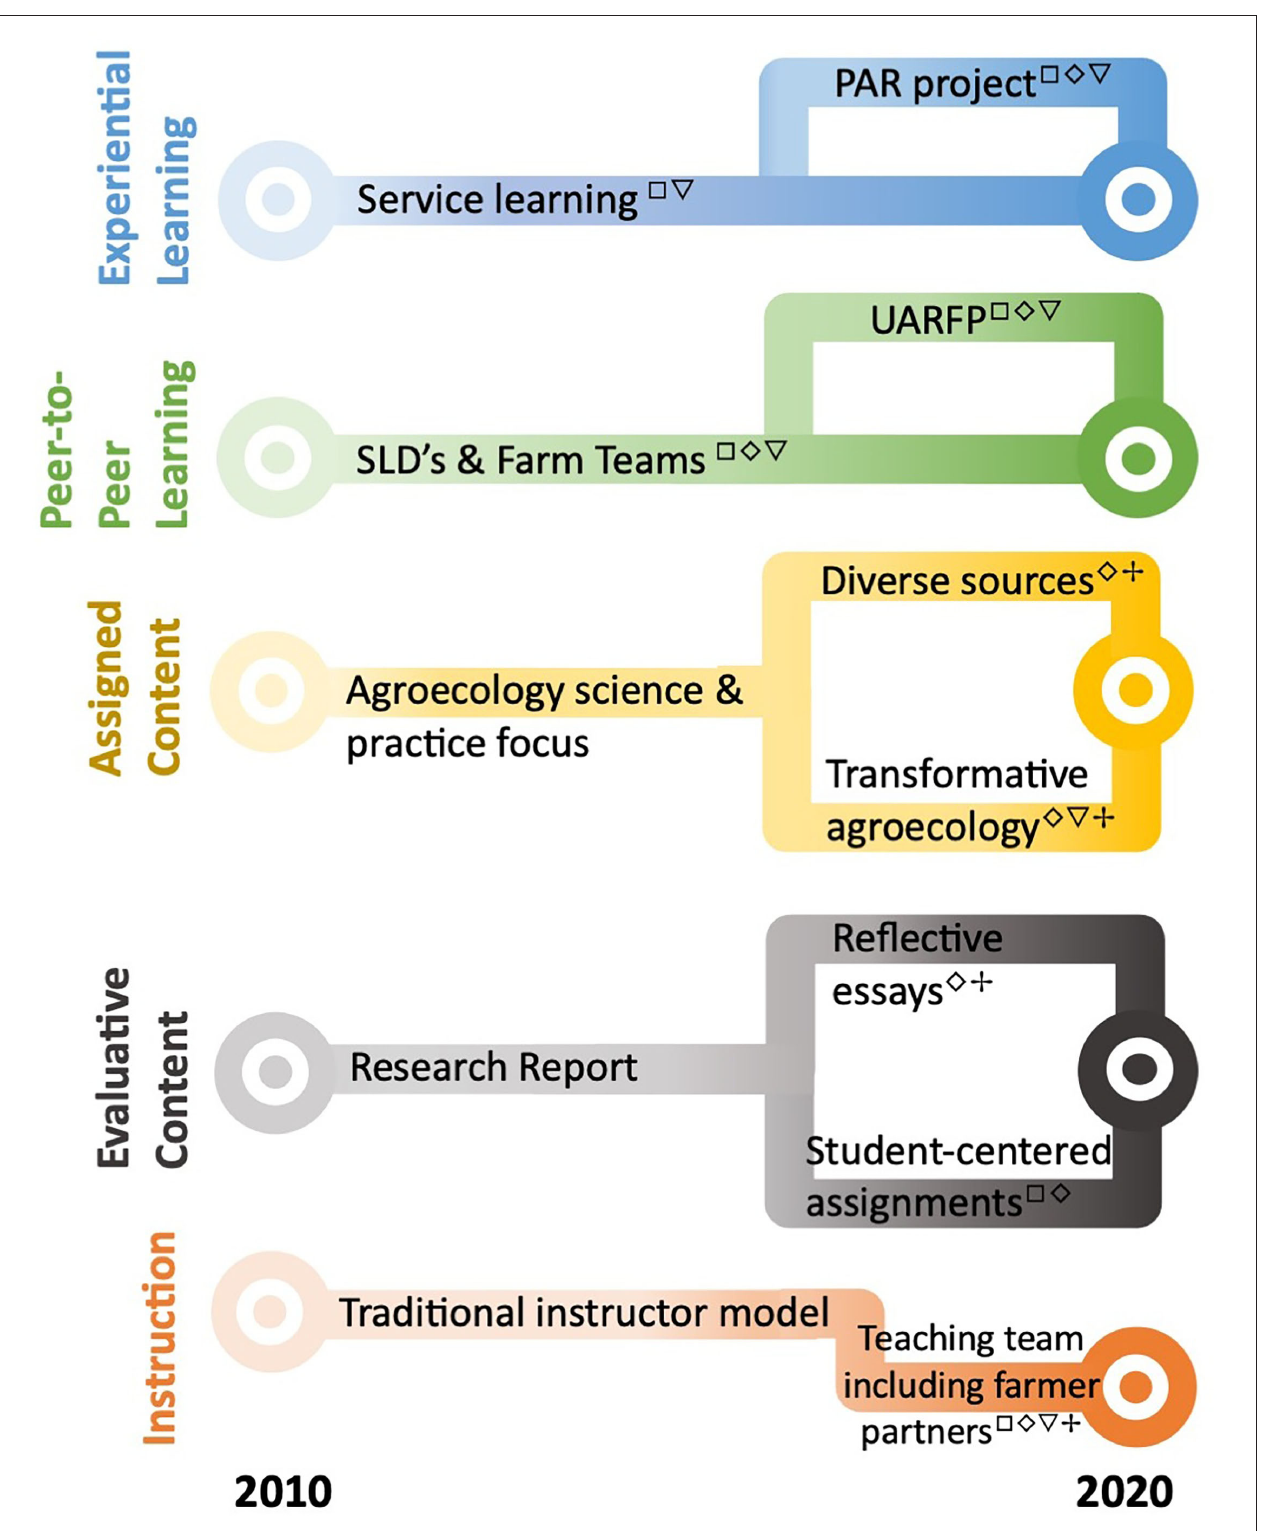
FIGURE 1 | This highlights the evolution of course pedagogy from 2010 to 2020. Major course components are grouped into pedagogical elements to provide a sense for how all elements of course pedagogy have co-evolved. The color saturation gradient represents the intentional shift over time toward pedagogies more aligned with a transformative approach to agroecology. Superscripts indicate the tenets of transformative agroecology supported by each pedagogical innovation: (cid:3) —Participatory, ⋄ —Transdisciplinary, ▽ —Action-oriented, + —Political.